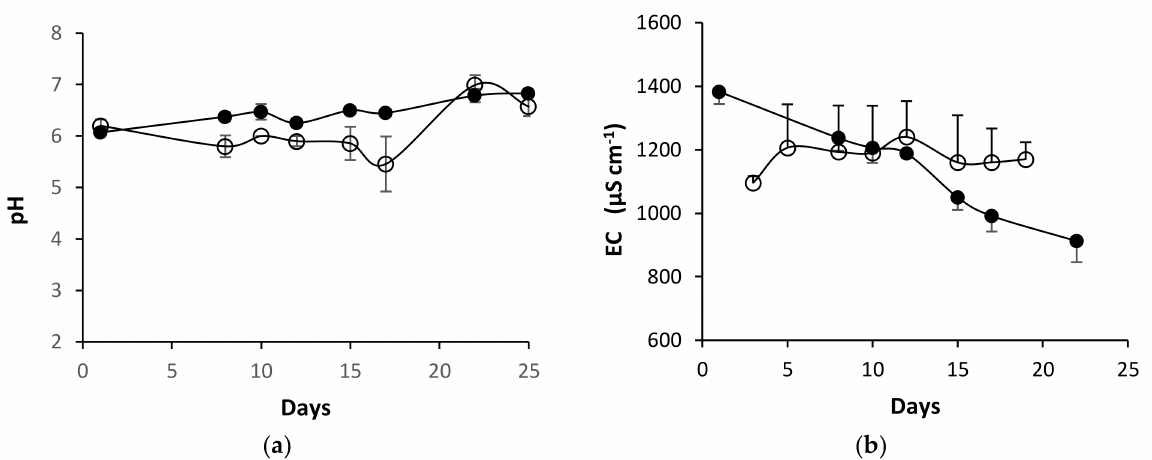
Figure 2. Variation in ( a ) pH and ( b ) EC in the organic ( • ) and conventional ( experimental